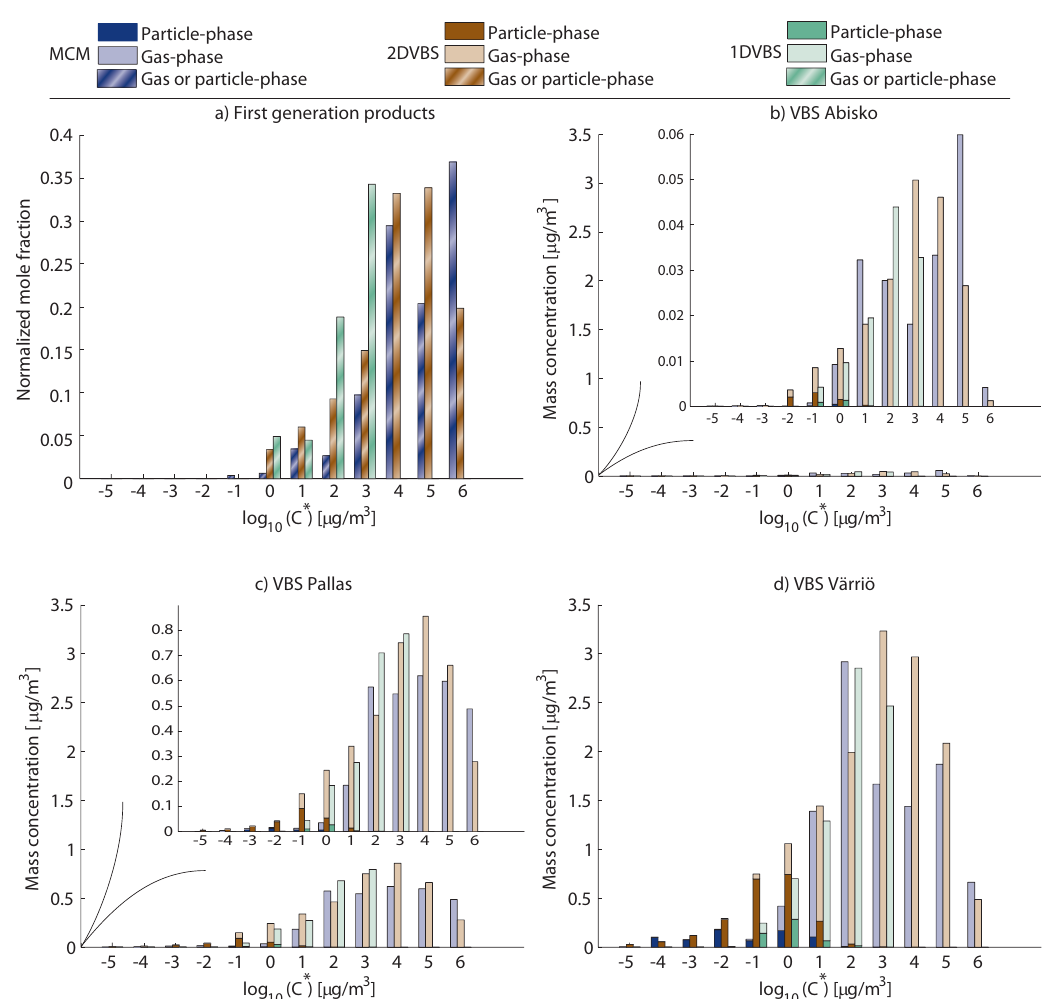
Figure 5. Volatility distribution of the oxidation products in both gas and particle phase from the MCM, 2DVBS and 1DVBS base case simulations. In (a) , only products from the first oxidation step are shown, while (b–d) include products from higher-generation oxidation as well. The distributions in (b–d) are at Abisko, Pallas and Värriö, respectively, the dark colors represent the portion of products in the particle phase and the light colors, the portion in the gas